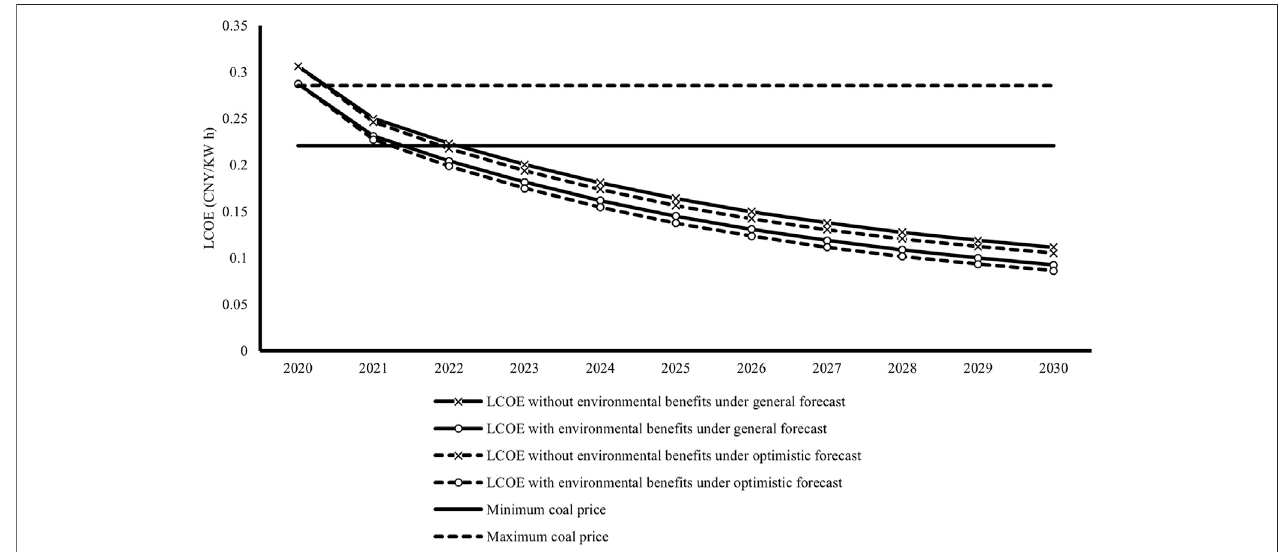
FIGURE 11 | LCOE of Ningxia centralized PV in four scenarios from 2020 to